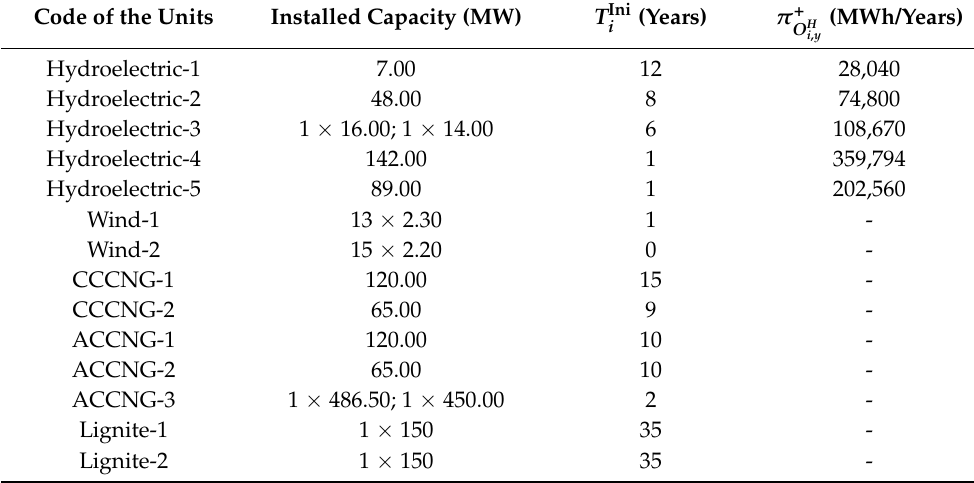
Table 2. Data of the existing generation units.